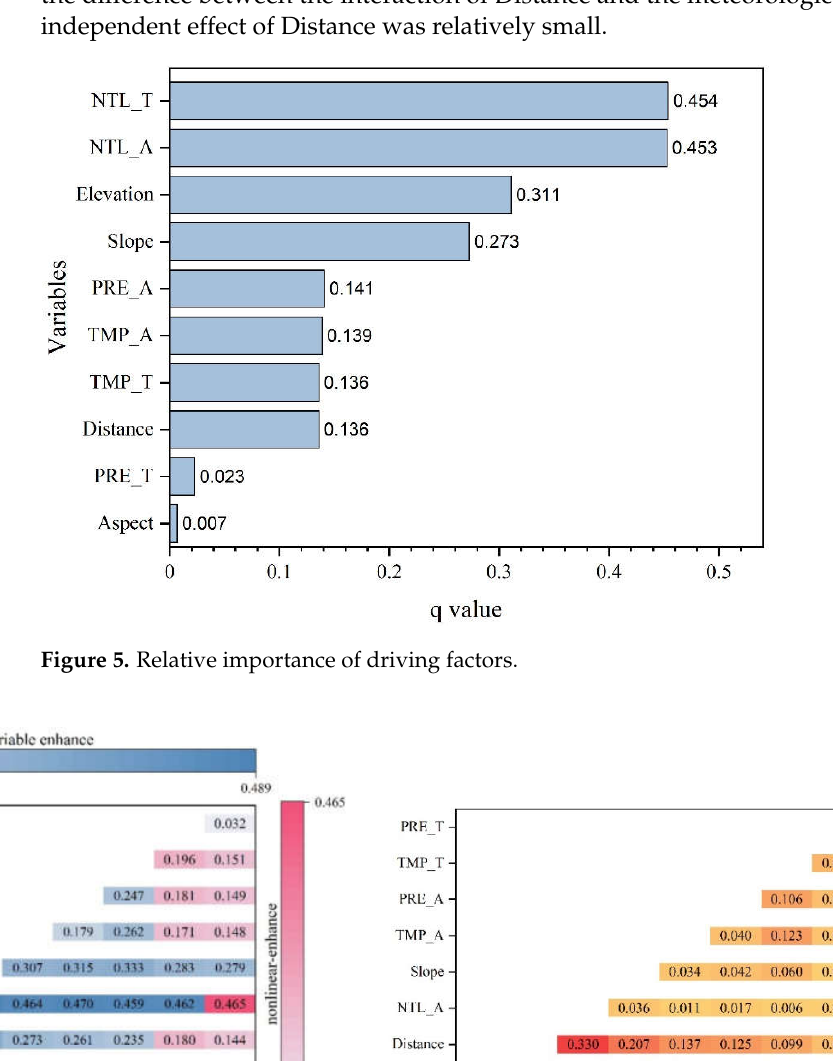
Figure 6. The interaction of factors on vegetation changes and the difference of q value between interactions and individuals. ( a ) The interaction of factors consisted of bi-variable enhance and